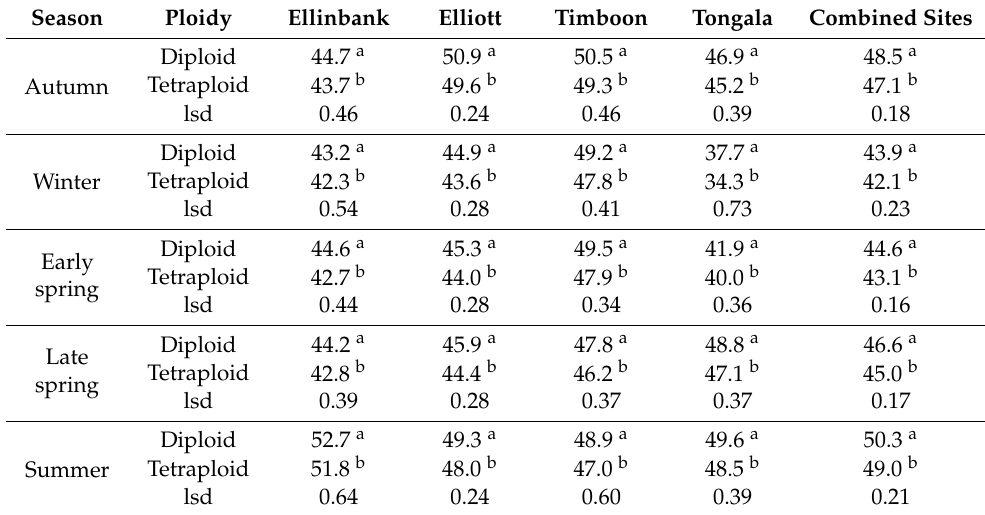
Table 5. Seasonal mean differences in neutral detergent fibre (% DM) across 3 years between all diploid and tetraploid perennial ryegrass candidates at 4 trial sites in south-eastern Australia. Season Ploidy Ellinbank Elliott Timboon Tongala Combined Sites Autumn